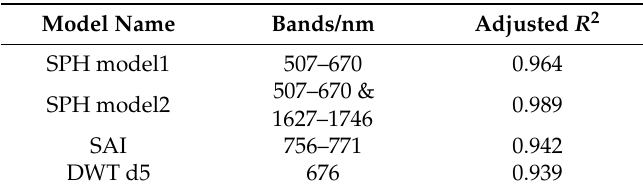
Table 2. Parameters of the prediction models.